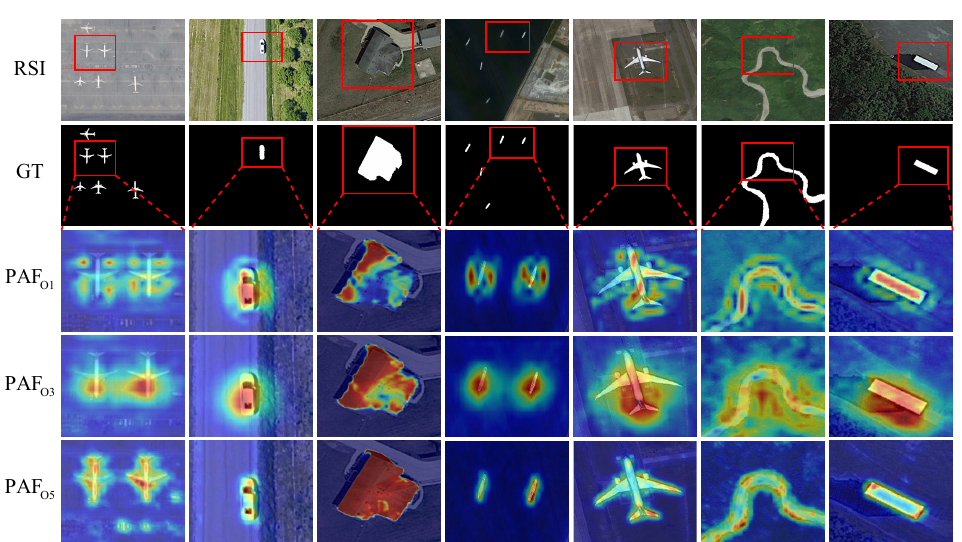
Figure 6. Feature visualization comparison of top-down PAF modules output PAF oi ( i means a particular step) with multi-step feedback